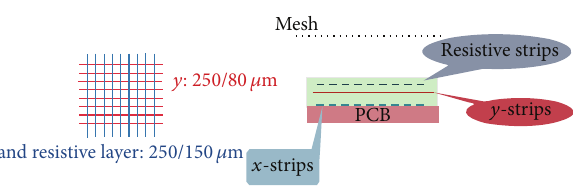
Figure 4: 𝑋 - 𝑌 Micromegas detectors showing the dimensions of the strips and the resistive layer. The resistive layer helps to limit the spark at high rate. The 𝑋 - 𝑌 module helps to determine the hit position of the incoming particle and track it precisely in the magnetic